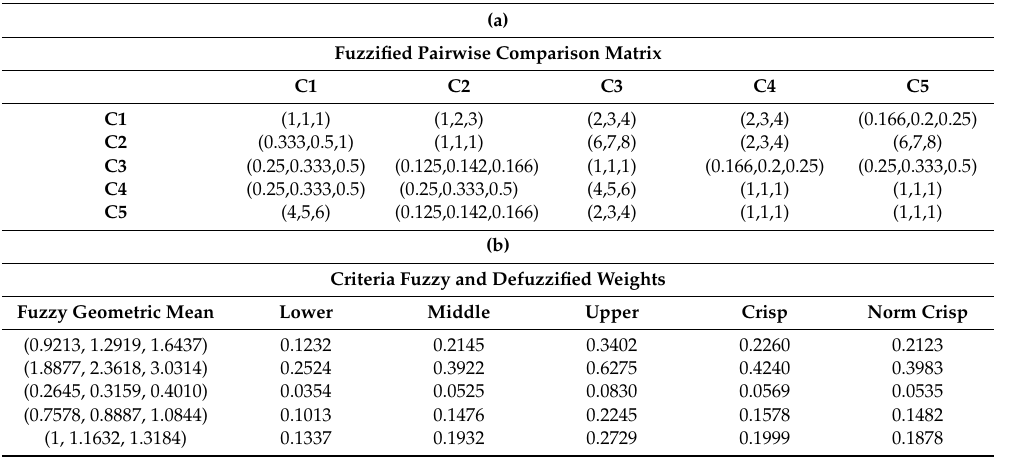
Table 6. SF-AHP results per criteria category for the category technological. ( a ) Fuzzified pairwise comparison matrix; ( b ) Criteria fuzzy and defuzzified weights.